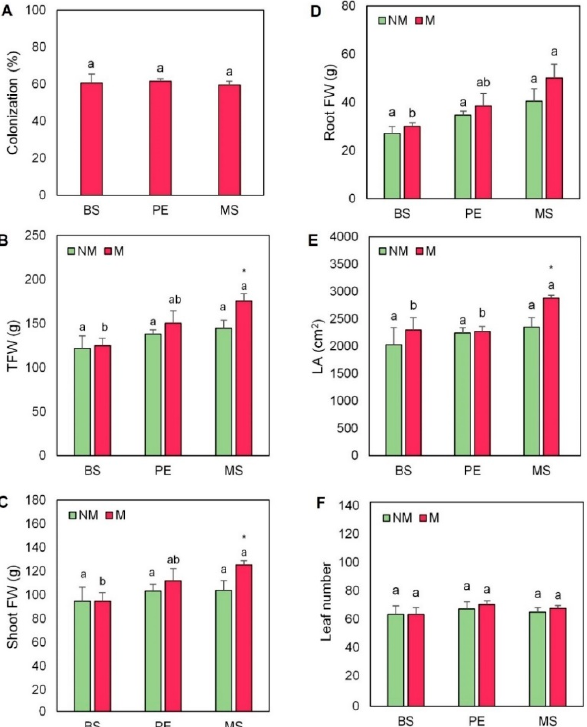
Plant growth was significantly affected by the application of mulching and AMF. The